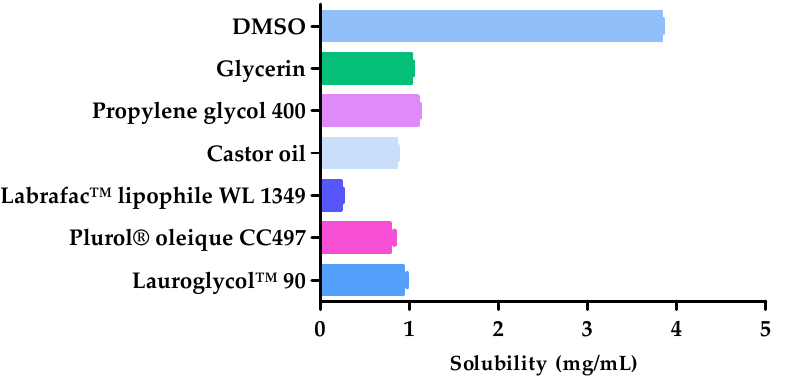
Figure 1. Amphotericin B (AmB) solubility in different excipients ( n = 3).